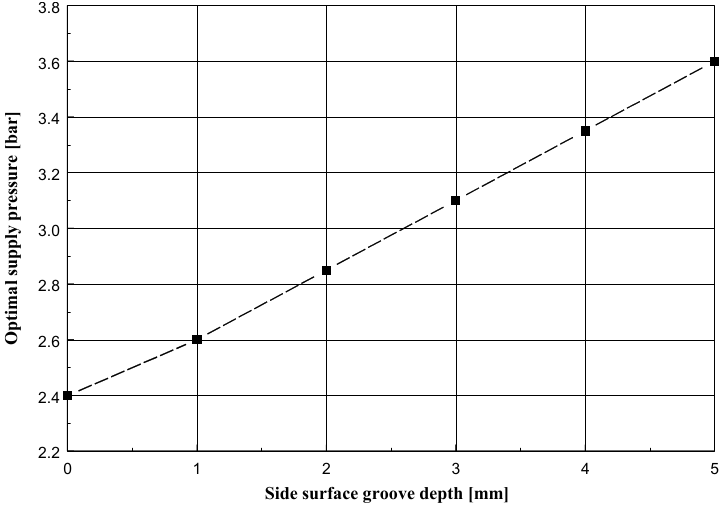
Figure 12. Optimal supply pressure p opt depending on depth of side surface groove h . Table 2. Optimal supply pressure (elastic-plastic model) of regenerated sand. Maximum Depth of the Side Surface Groove h